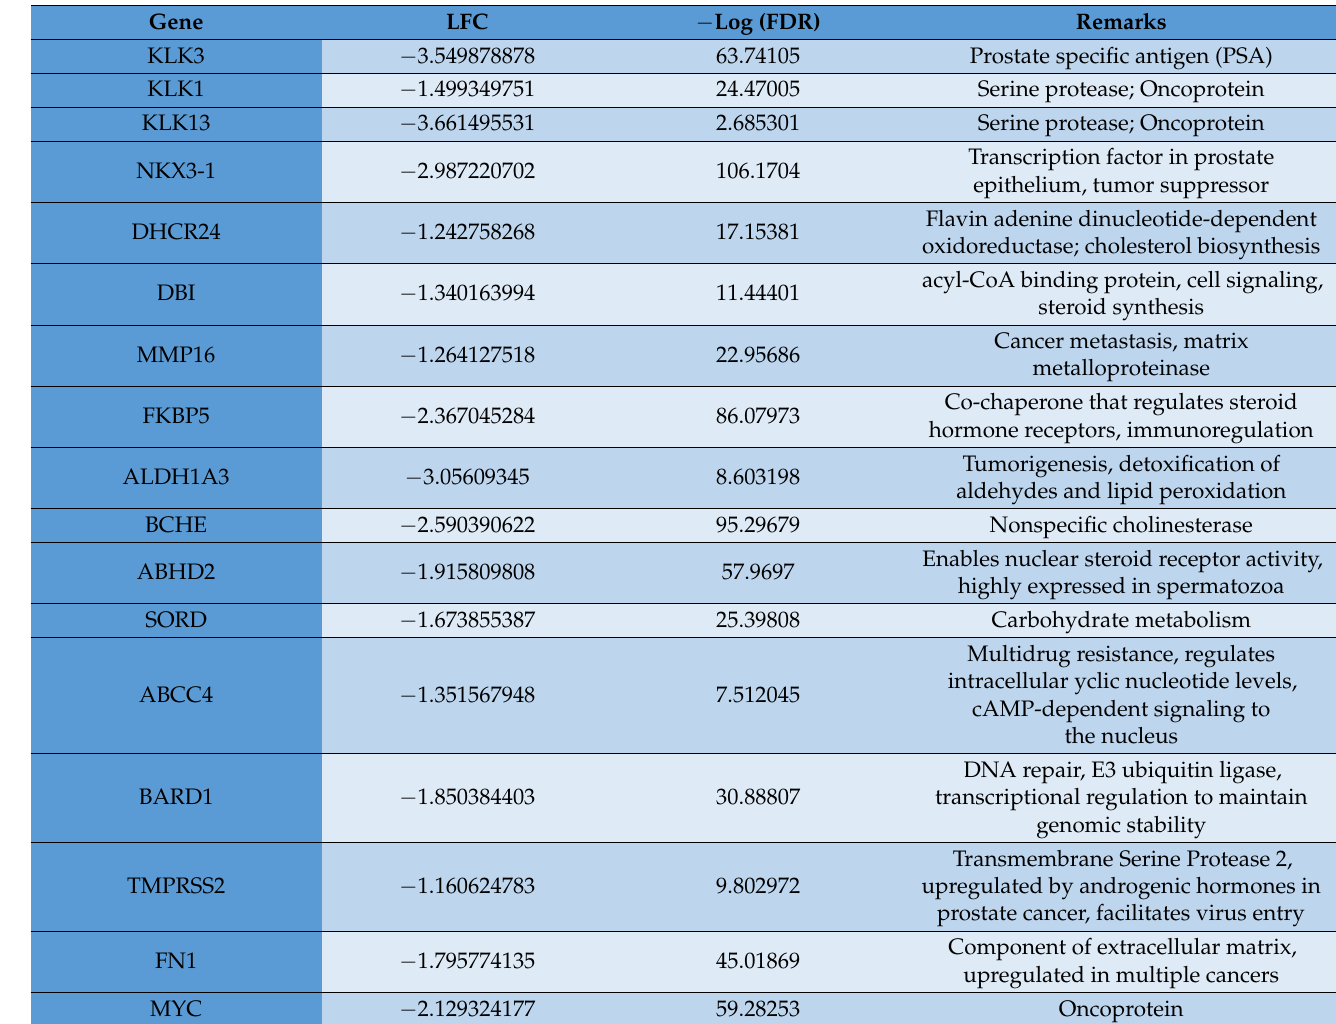
Table 1. The genes that are transcriptional targets of AR [29] found to be downregulated upon VNPP433-3 β treatment as revealed by RNA sequencing. All genes except NKX3-1 play crucial role in